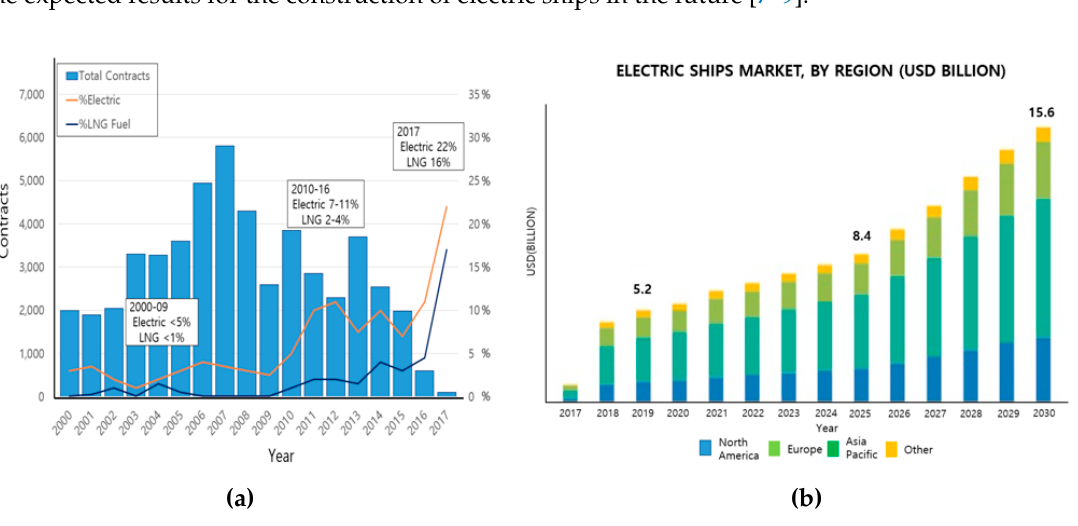
Figure 1. ( a ) Electric propulsion ship contract status and ( b ) market forecast (Clarkson Research, 2017; Market Research Report, 2019) .